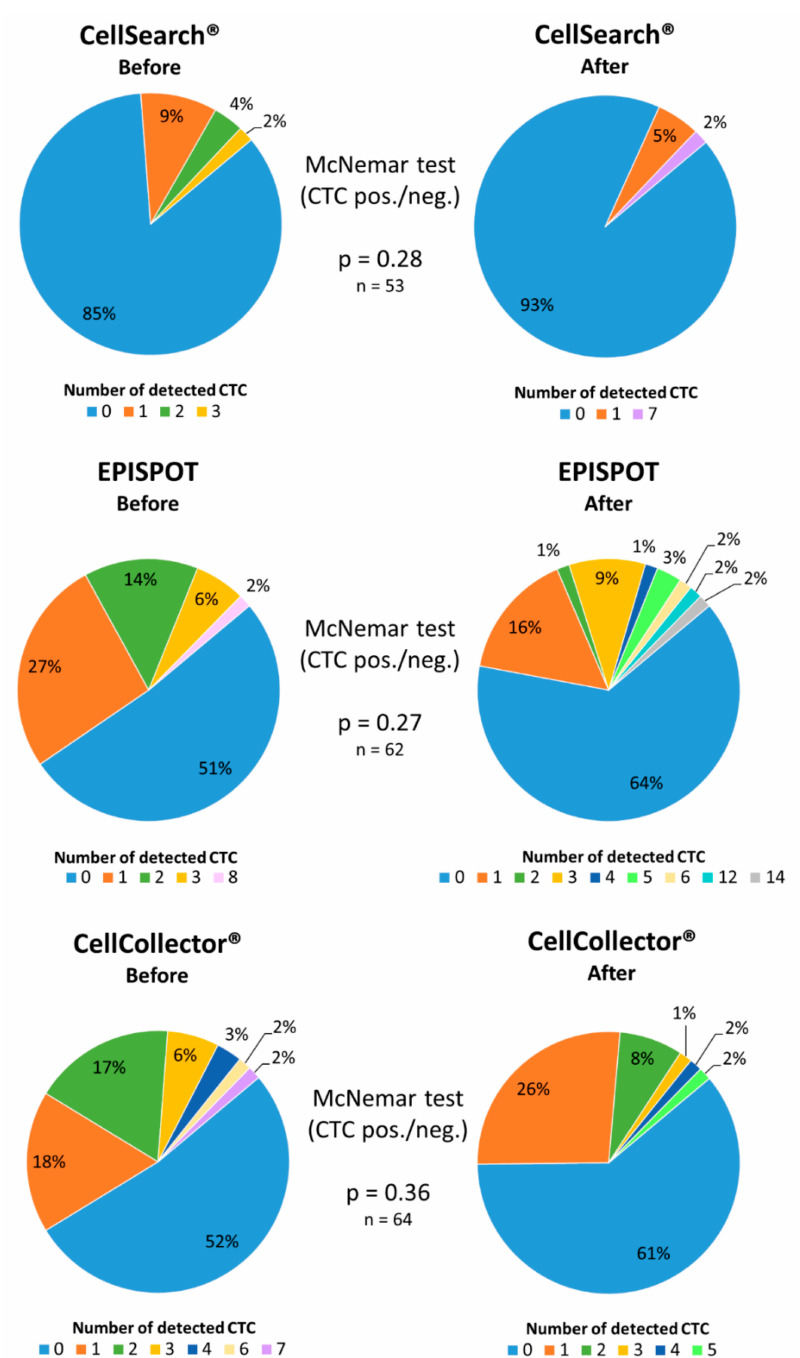
Figure 6. Matched-pair analysis of CTCs quantified with the CellSearch ® , dual fluoro-EPISPOT PSA / FGF2 or CellCollector ® assay before and at least three months after radiotherapy